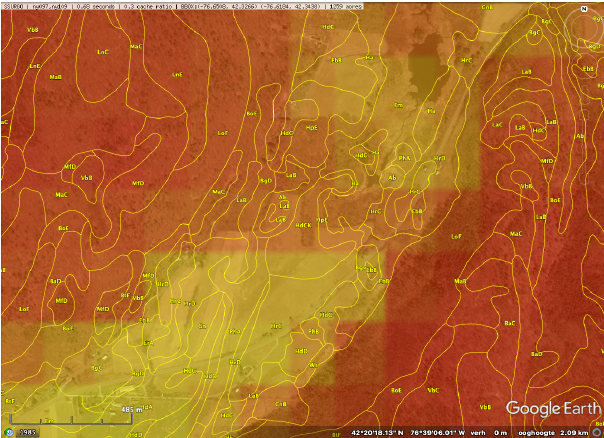
Figure 3. SoilWeb view of the SSURGO map units and a ground overlay of pH, at 0–5cm, predicted by SG2. The colours are low (red) to yellow (high) pH. The centre is at − 76 ◦ 38 (cid:48) 04 (cid:48)(cid:48) E, 42 ◦ 20 (cid:48) 07 (cid:48)(cid:48) N. An interactive view of SSURGO is available at https://casoilresource.lawr.ucdavis.edu/gmap/?loc=42. 33215,-76.63590,z15 (last access: 18 August 2022). The back- ground is from © Google Earth. Table 1. Statistical differences between gNATSGO and DSM prod- ucts for pH × 10 at 0–5cm. DSM product MD RMSD RMSD.Adjusted SG2 3.796 6.111 4.789 PSP 3.843 4.908 3.052 SPCG 4.815